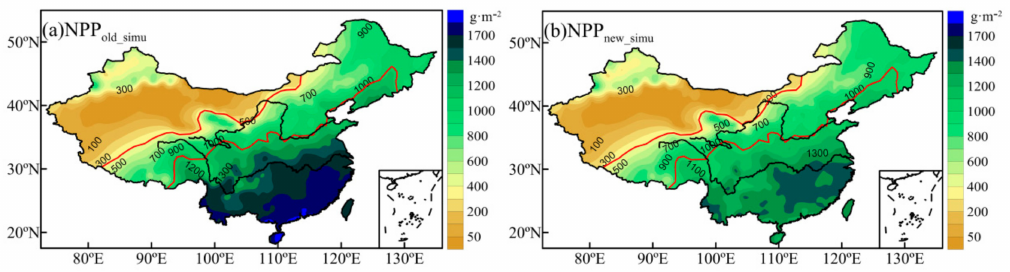
Figure 6. NPP distribution before ( a ) and after( b )